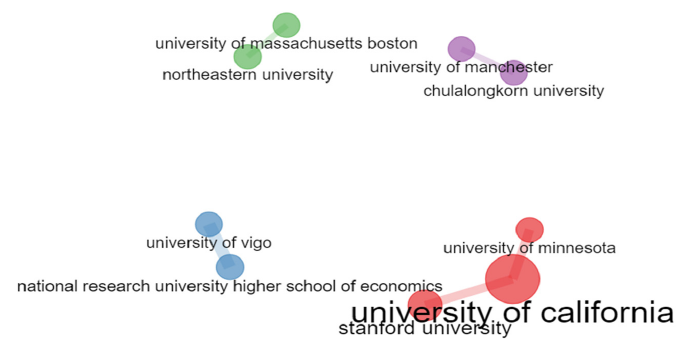
Figure 6. Leading Institutions Contributing to EVA Research (Minimum of Five Articles).